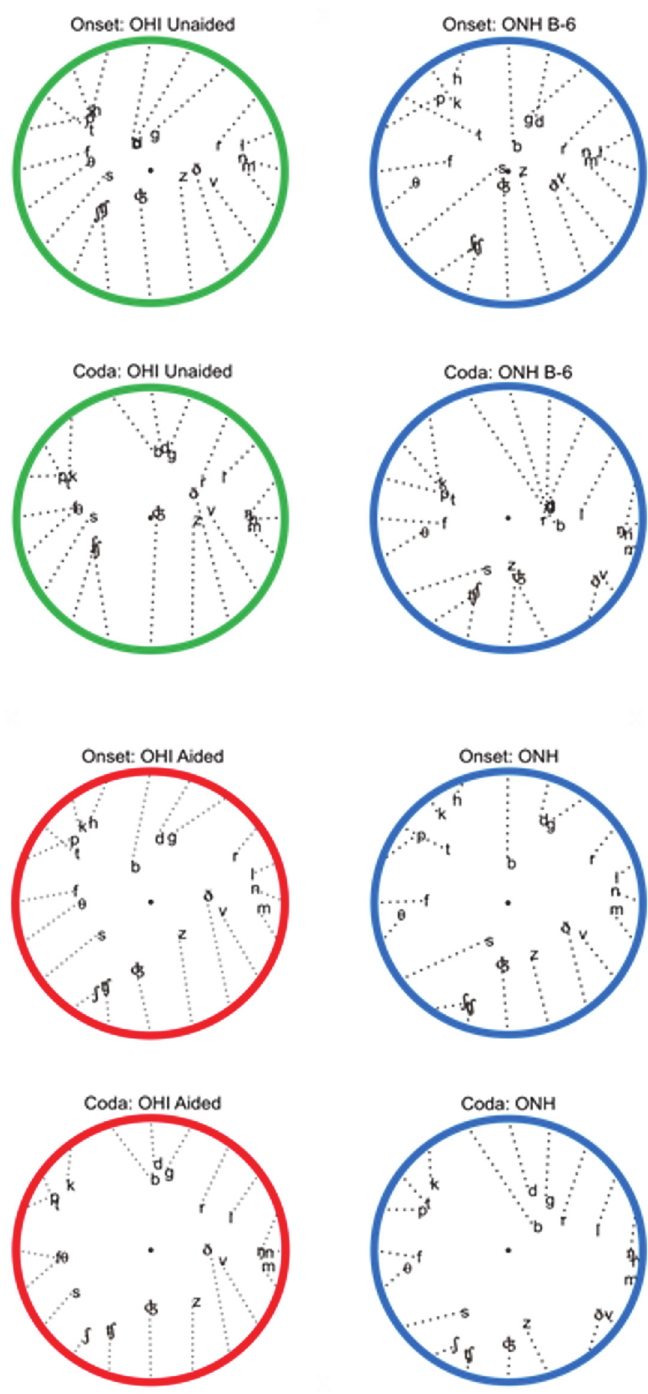
Fig 6. Barycentric plots for unaided (green) and aided (red) OHI listeners, and for ONH listeners (blue) in SNR conditions producing similar overall consonant identification performance.